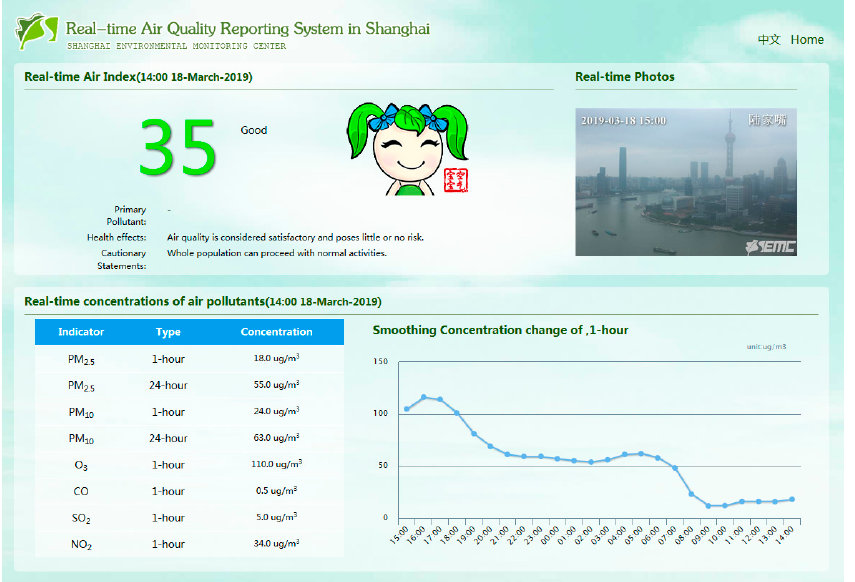
Figure 3. Interface of a website in China showing the AQI